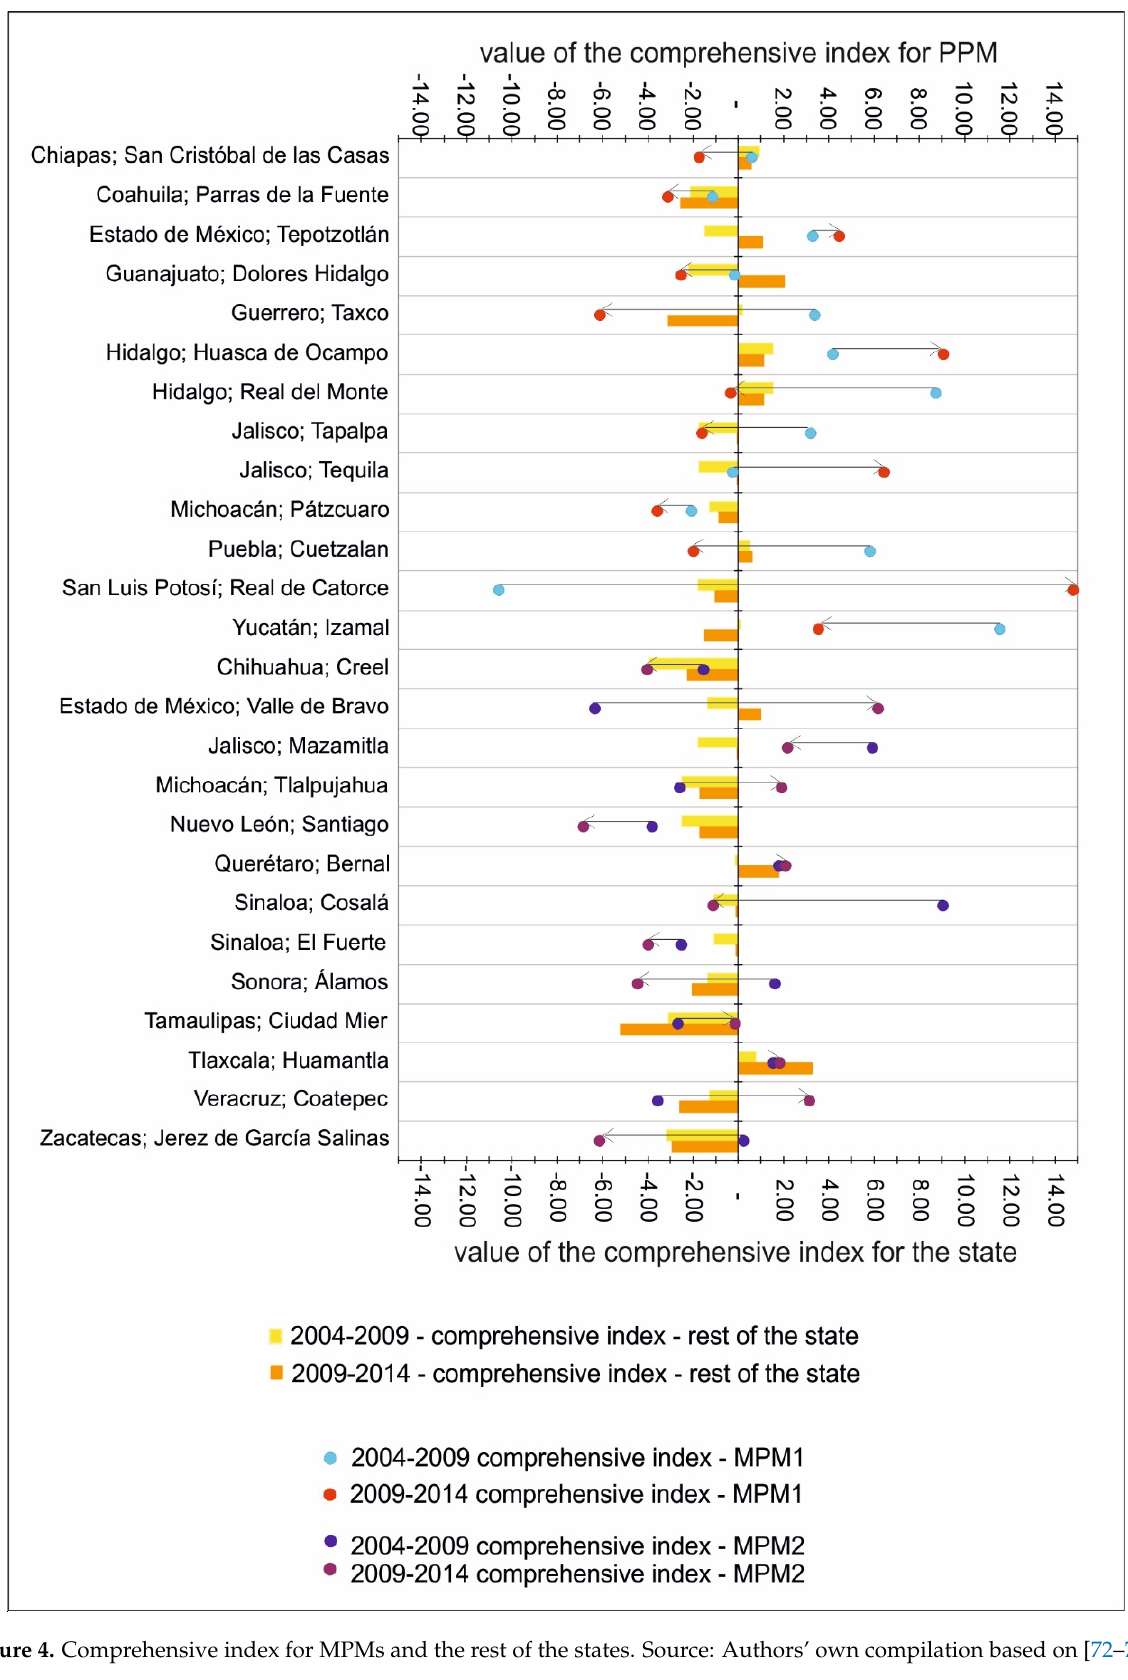
Figure 4. Comprehensive index for MPMs and the rest of the states. Source: Authors’ own compilation based on [72–74].